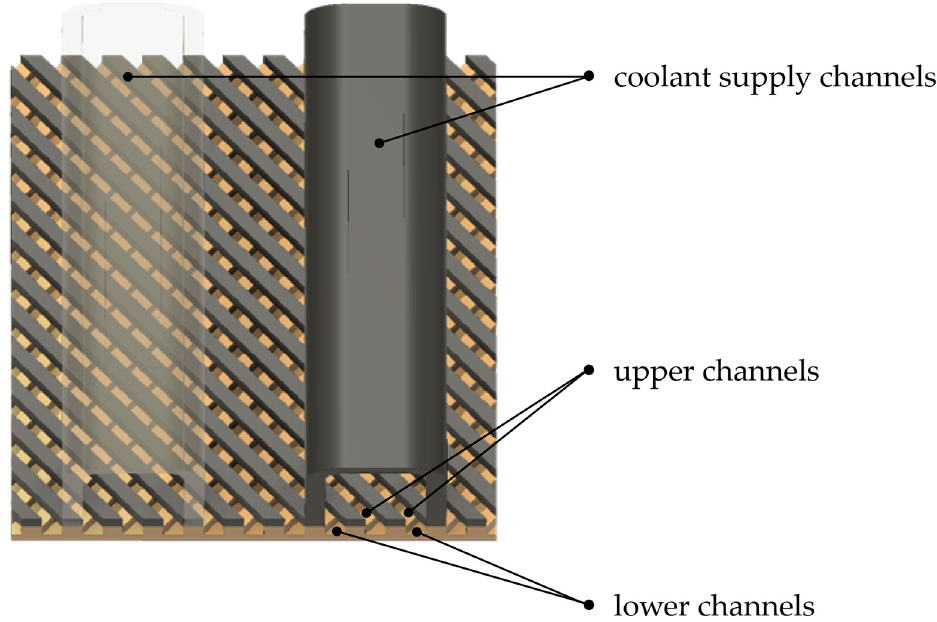
Figure 1. General design concept with distribution channels (the left one semitransparent for better insight into the lower grid).